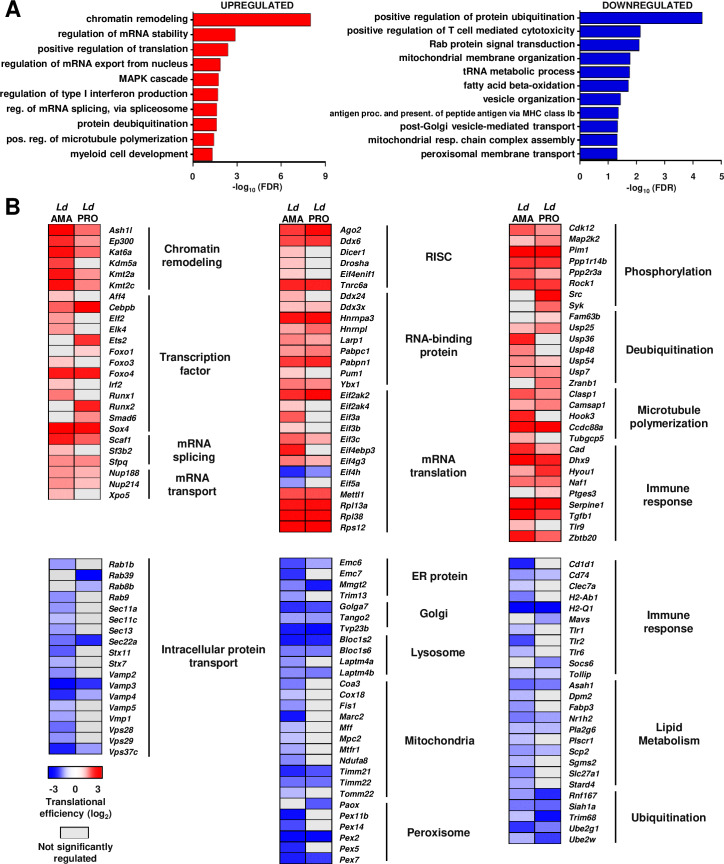
L. donovani infection-dependent translation targets core and immune cell functions.(A) FDR values (-log10) for selected GO term enriched categories for translationally up- and down-regulated host mRNAs upon L. donovani infection. (B) Heatmaps showing changes in translational efficiencies for selected genes in enriched GO terms. Analyses were carried out on data generated from at least three biological replicates.